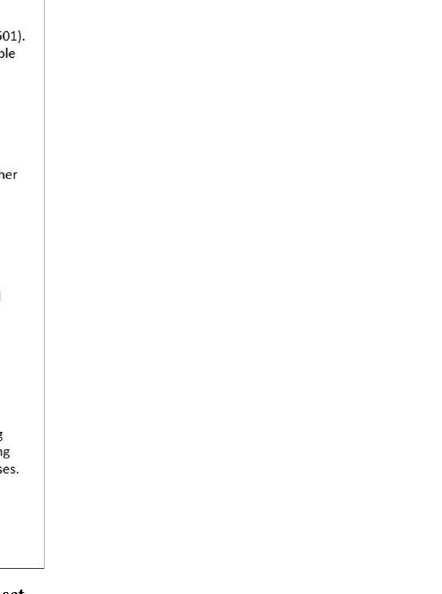
Fig 1. Flowchart of the selection process for the